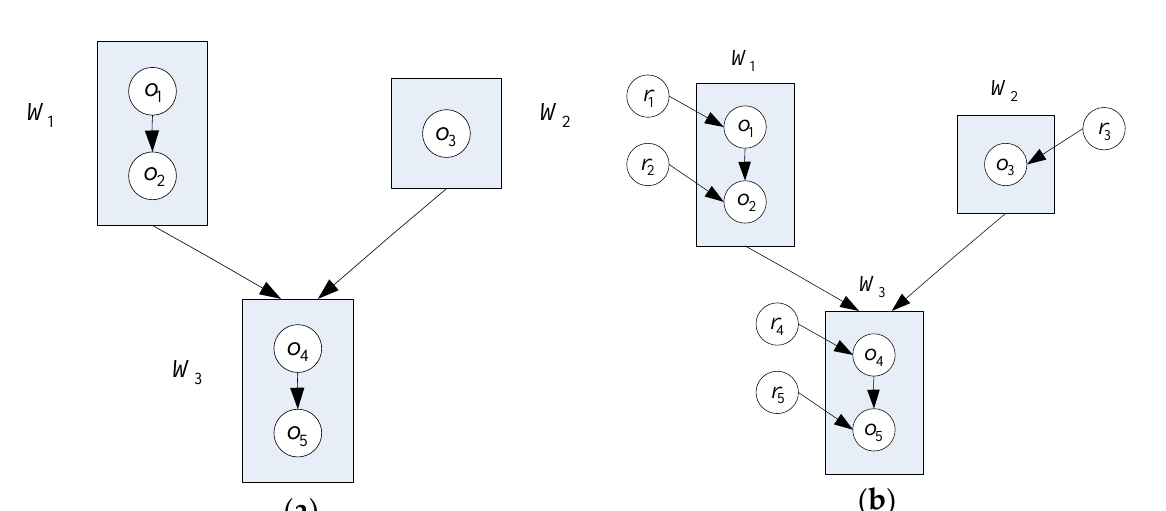
Figure 3. ( a ) Operations in three process agents and dependency among workflows; ( b ) dependency on resources for operations.